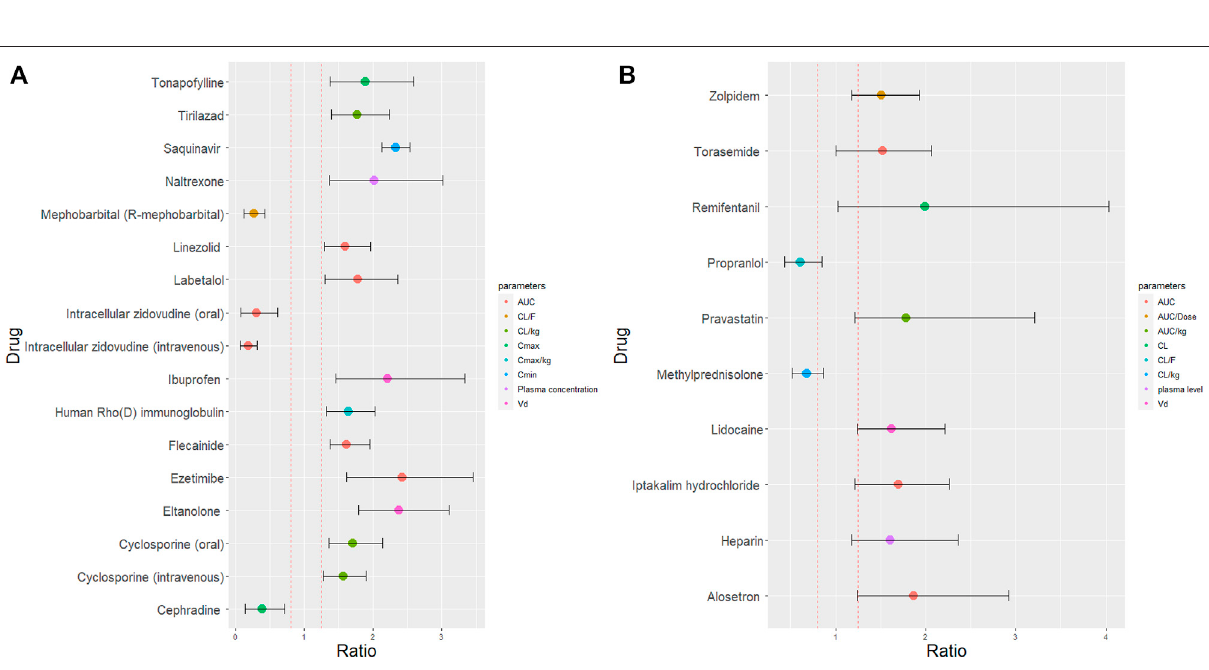
FIGURE3| FemaletomaleratioofobservedPKparametersofdrugswithatleast50%sexdifferencesinPK.Theratiorangesforall25drugsfrom0.19(smallerPK valueinwomen)to2.38(higherPKvalueinwomen).Reddashedlinesindicatethebioequivalencewindowfrom0.8to1.25.The90%con fi denceintervalareindicatedby the error bars which either fell outside the bioequivalence window (A) or inside the bioequivalence window (B) . Where, AUC is area under curve; CL is clearance (correctedforbodyweight)(CL/kg);CL/Fisoralclearance; Cmaxismaximumplasmaconcentration(corrected forbodyweight)(Cmax/kg);Cministroughplasma concentration and Vd is volume of